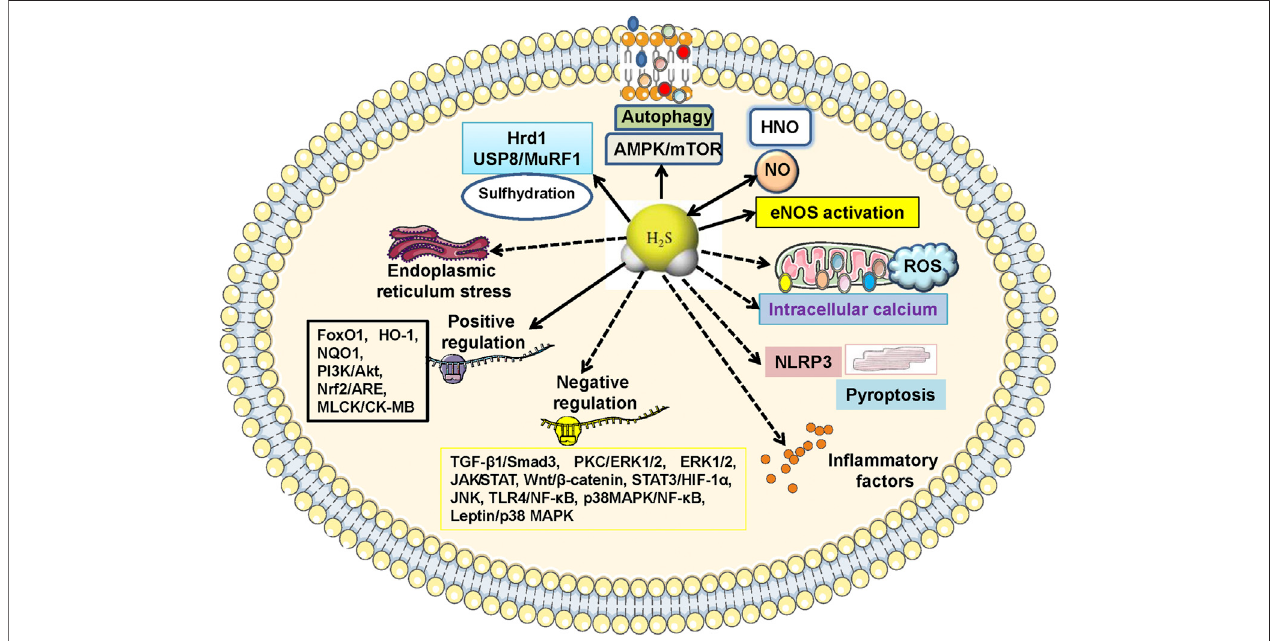
FIGURE5| MolecularmechanismsofH2S-mediatedcardiacbene fi tsindiabeticcardiomyopathy.ThecardioprotectiveactionsofH 2 Sondiabeticcardiomyopathy are regulated by multiple signaling cascades. Speci fi cally, 1) inactivation of TGF- β 1/Smad3, PKC/ERK1/2, ROS/ERK1/2, JAK/STAT, Wnt pathways, and activation of MLCK/CK-MB, PI3K/AKT, Nrf2/ARE, are responsible for H 2 S-mediabted suppression on myocardial fi brosis and hypertrophy; 2) blockade of endoplasmic reticulum stress, Wnt/ β -catenin, STAT3/HIF-1 α , JNK/p38 MAPK, NLRP3, TLR4/NF- κ B, p38 MAPK/NF- κ B, while stimulation of PI3K/Akt, FoxO1, HO-1, NQO1, contribute to H 2 S-induced effects against cardiomyocyte apoptosis, oxidative stress and in fl ammation; 3) regulations of intracellular calcium, leptin/p38 MAPK, NLRP3-mediated pyroptosis, AMPK/mTOR, autophagy, eNOS activation, formation of HNO, are also proposed to H 2 S-mediated cardiac bene fi ts in diabetic cardiomyopathy. AMPK, adenosine5 ′ -monophosphate (AMP)-activated protein kinase; ARE,antioxidantresponseelement; CK-MB, creatinekinase MB isozyme; eNOS, endothelialnitric oxide synthase; ERK1/2, extracellular regulated protein kinase 1/2; FoxO1, forkhead box O1; HIF-1 α , hypoxia-inducible factor-1 α ; HNO, nitroxyl; HO-1, haem oxygenase-1; JAK, Janus kinase; JNK, c-Jun N-terminal kinase; MAPK, mitogen-activated protein kinase; MLCK, myosin light chain kinase; mTOR, mammalian target of rapamycin; NLRP3, nucleotide-binding oligomerization domain-like receptor protein 3; NF- κ B, nuclear factor kappa-B; NQO1, NAD(P)H:quinone oxidoreductase 1; Nrf2,